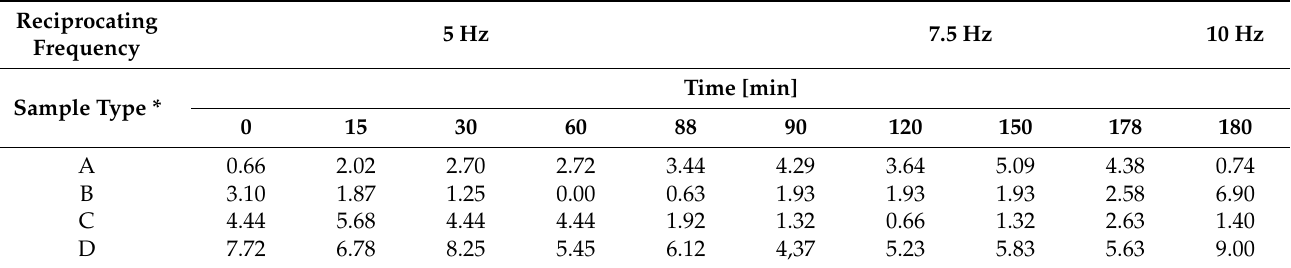
Table 3. Relative dispersion of the friction force [%].